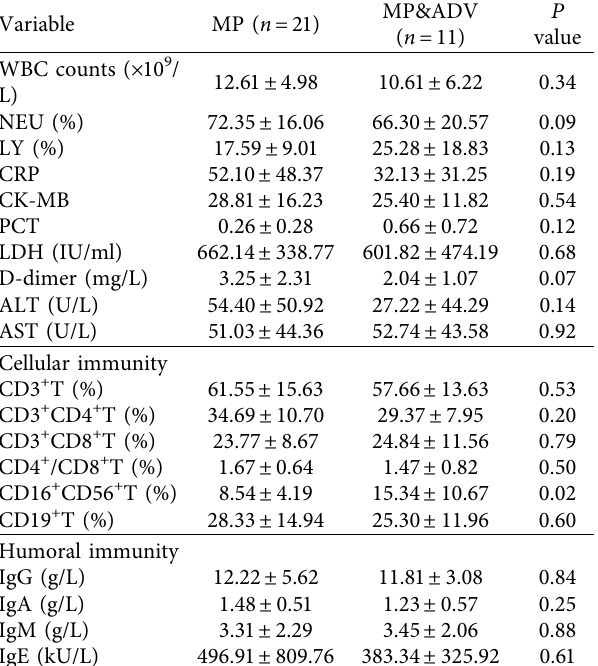
Table 2: Laboratory